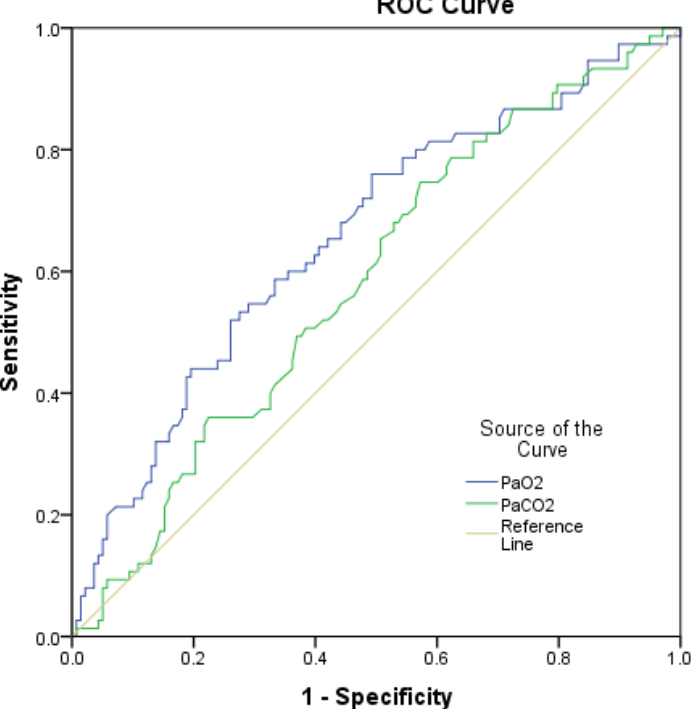
Figure 2. Accuracy of increased effort of breathing prediction. ROC-AUC for PaO2 of 0.656 (CI 95%: 0.579–0.734, p < 0.001), ROC-AUC for PaCO2 of 0.584 (CI 95%: 0.505–0.662, p = 0.043). PaCO2—partial pressure of carbon dioxide in arterial blood, PaO2—partial pressure of oxygen in arterial blood. The last step of the analysis was a multivariate regression of all the possible deter- minants of the increased EOB. Separate models were generated for clinical signs, arterial blood gas analysis and laboratory findings. Variables with mean values different across two different EOB groups were included in the analysis. In the clinical signs model, MAP, heart rate, SpO2, and PaO2/FiO2 ratio were included. In the final multivariate model, the SpO2 (exp(B) = 0.922, CI 95%: 0.874–0.973 p = 0.033) and PaO2/FiO2 ratio (exp(B) = 0.996, CI 95%: 0.922–1.000, p = 0.003) prevailed as independent predictors. In the blood gas model, only PaO2 remained as an independent predictor of increased EOB (exp(B) = 0.989, CI 95%: 0.982–0.996, p = 0.003). None of the laboratory findings were significant predictors of effort of breathing. Results are presented in Table 5. Table 5. Multivariate regression analysis of increased effort of breathing determinants. Univariate Regression